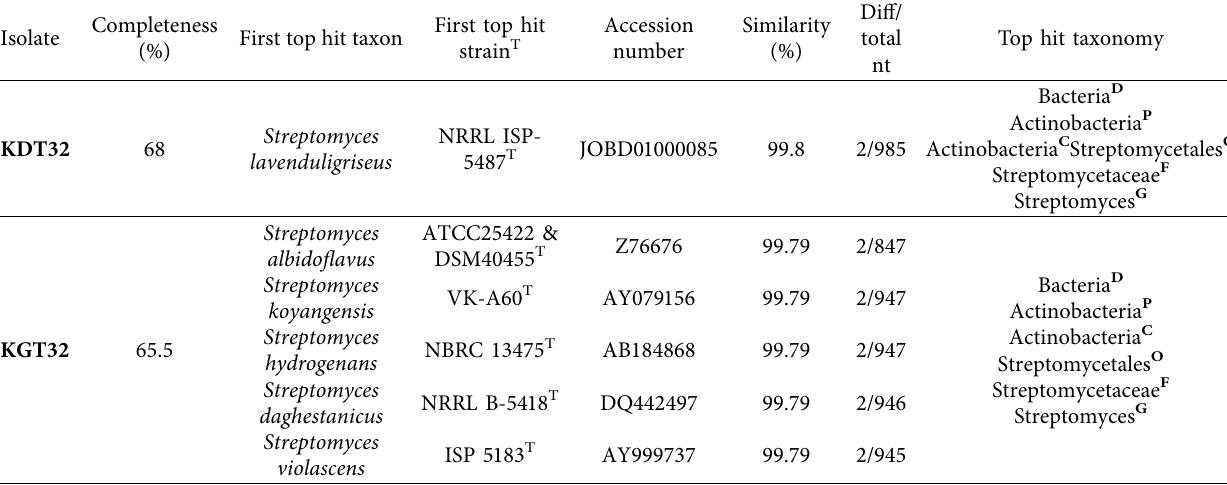
Table 4: The KDT32 and KGT32 sequence analysis using EzTaxon